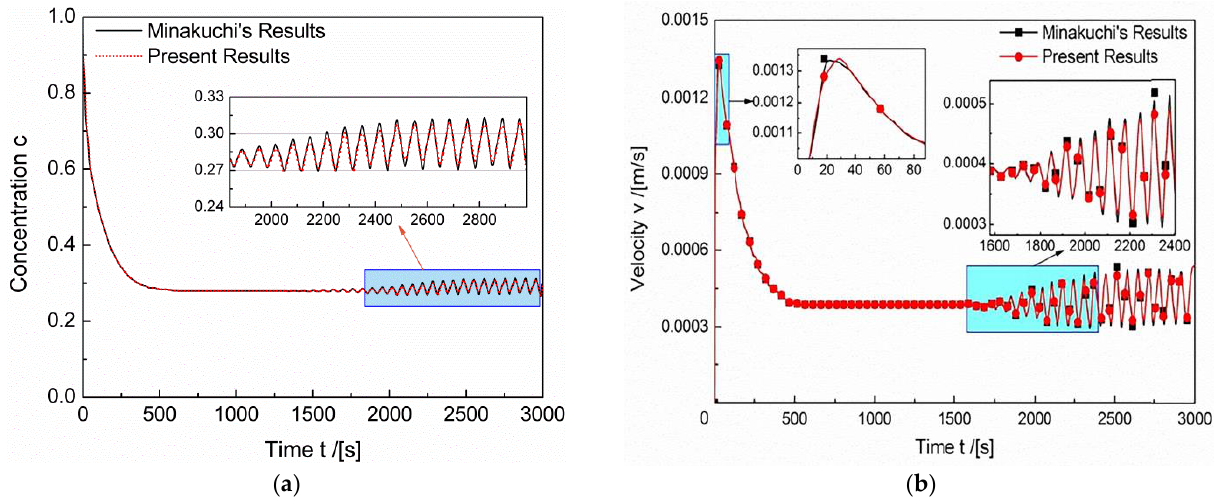
Figure 2. ( a , b ) Concentration and velocity comparison of monitoring point near intermediate height ( Ma C = 1107, Sc = 14). ( Ma C = 1107, Sc =